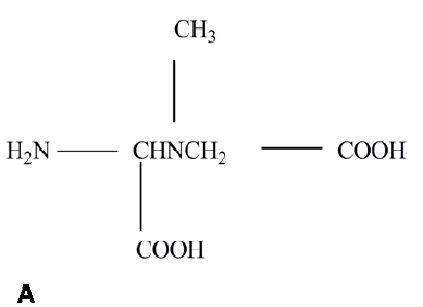
Figure 2. Comparison of the structure of ( A ) β -carbamate (BMAA adduct) and ( B ) glutamtic acid